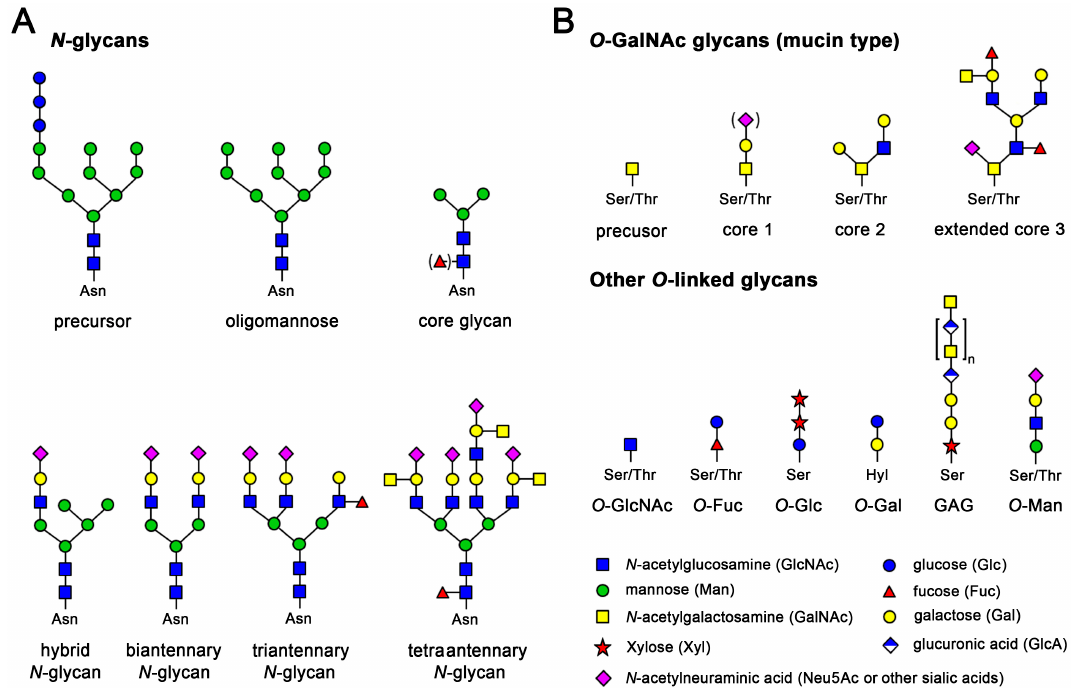
Figure 1. Examples of the most relevant types of glycosylation according to the literature [3,27]. ( A ) N -glycosylation of asparagine in sequons with the consensus sequence Asn-Xaa-Ser/Thr. N -glycans are generated by trimming and extending the common precursor GlcNAc 2 Man 9 Glu 3 . Small core glycans are mostly intermediates in mammalian glycan synthesis, but often occur in more primitive eukaryotes and insects, as used for recombinant expression. Mammalian N -glycans exhibit an enormous diversity, due to many possible combinations of branching sugars; ( B ) O -glycosylation at Ser and Thr is found in all kingdoms of life. There is no distinct consensus sequence, but proline-rich regions are favored, e.g., a typical O -glycan site would be Pro-Ser/Thr-Xaa-Yaa-Pro. A very common mammalian O -glycan is the mucin-type that starts with GalNAc and is extended by galactose and sialic acids or GlcNAc, with eight different cores known. In addition, the O -xylose linked, non-branched glucosamine glycans (GAG) or proteoglycans are a large and diverse glycan family. The displayed chondroitin can be phosphorylated and heavily sulfated, comprising up to fifty disaccharide units. O -GlcNAc glycans occur inside cells, even in the nucleus, while O -galactosylation is found at hydroxylysine residues (Hyl) of collagens.